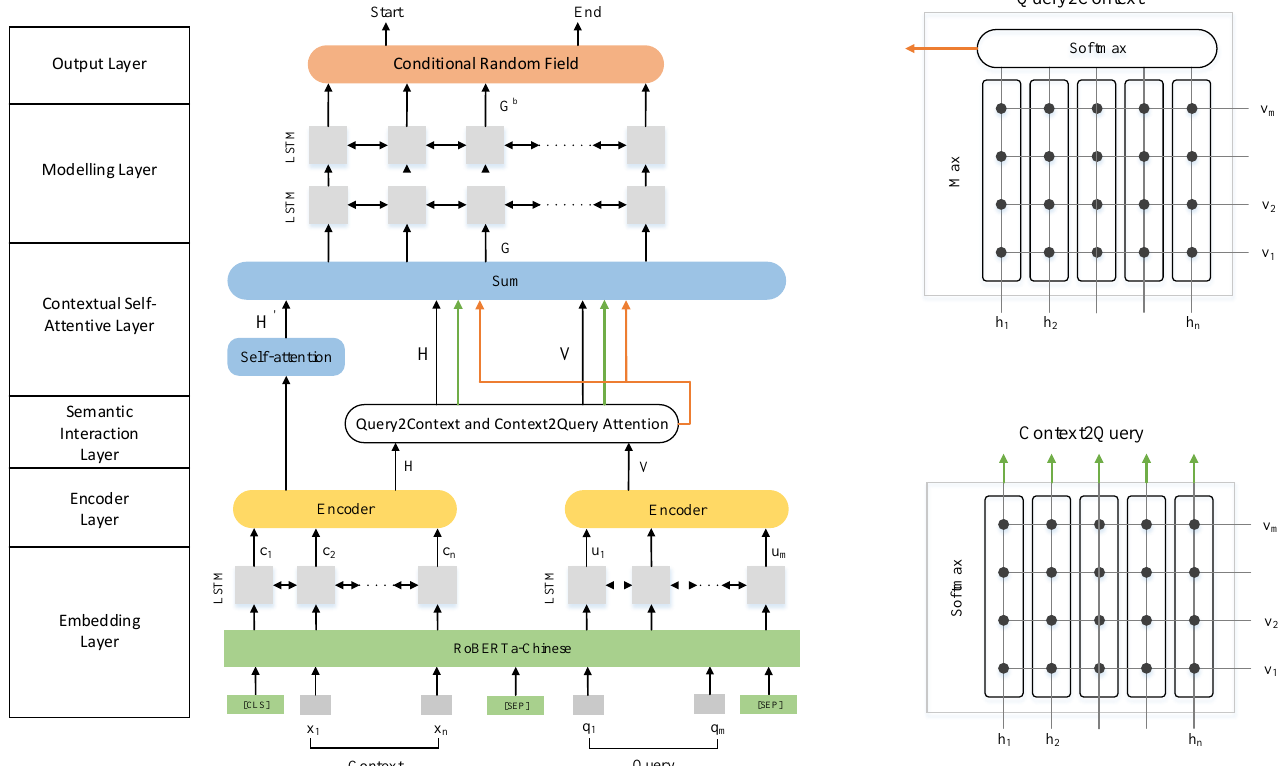
Figure 3. The overall architecture of the AT-CRF Reader reading comprehension model, with the bidirectional attention flow mechanism on the right, where x and q are the input context and query, c and u are the initial vector representations of the context and the query obtained after the embedding layer processing, H and V are the contextual vector representations of the context and the query respectively, ˜ H contains the most important word information of the query in the context, ˜ V contains the correlation representation of the query word and each context word, and H (cid:48) is the self-attention representation of the whole context, G is the splicing and fusion of the output of the semantic interaction layer and the contextual self-attentive layer. G b embeds information about the entire context and query through the